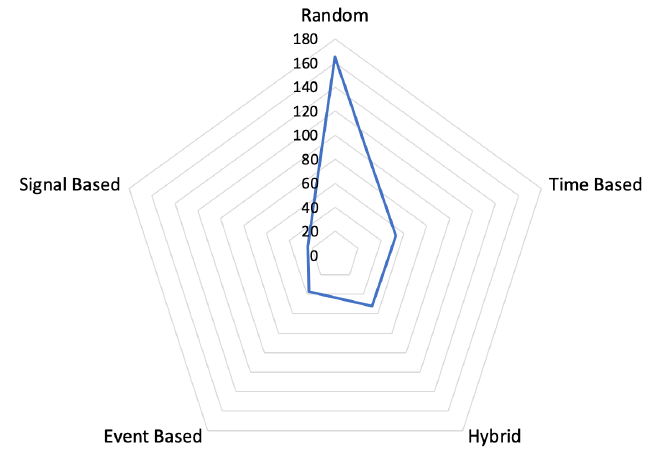
Figure 8. Types of the experience sampling method.